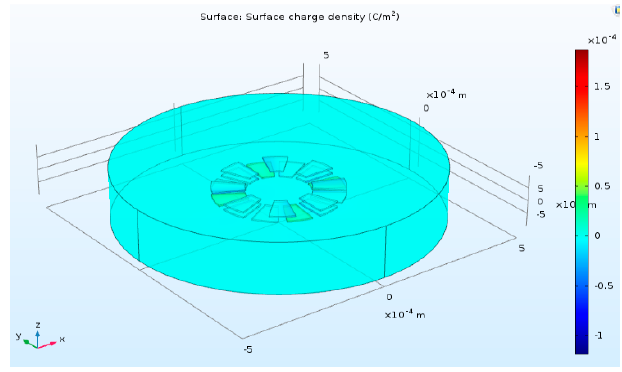
Figure 8. Rotary actuator model for torque and electric charge analysis.